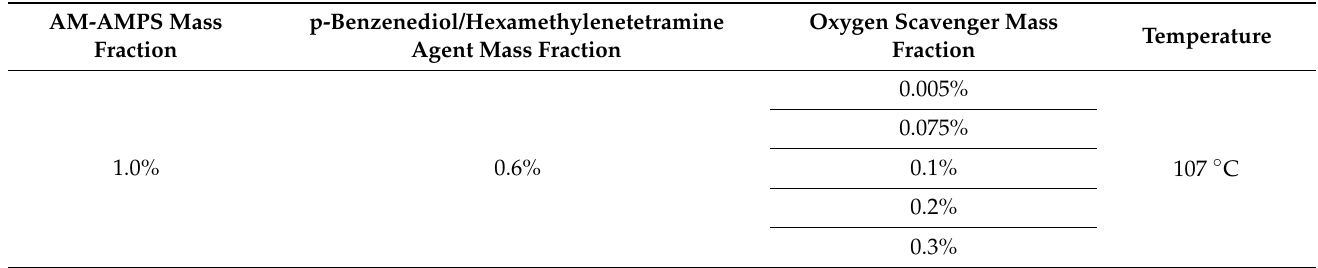
Table 5. Scheme of the oxygen scavenger mass fraction optimization experiment.